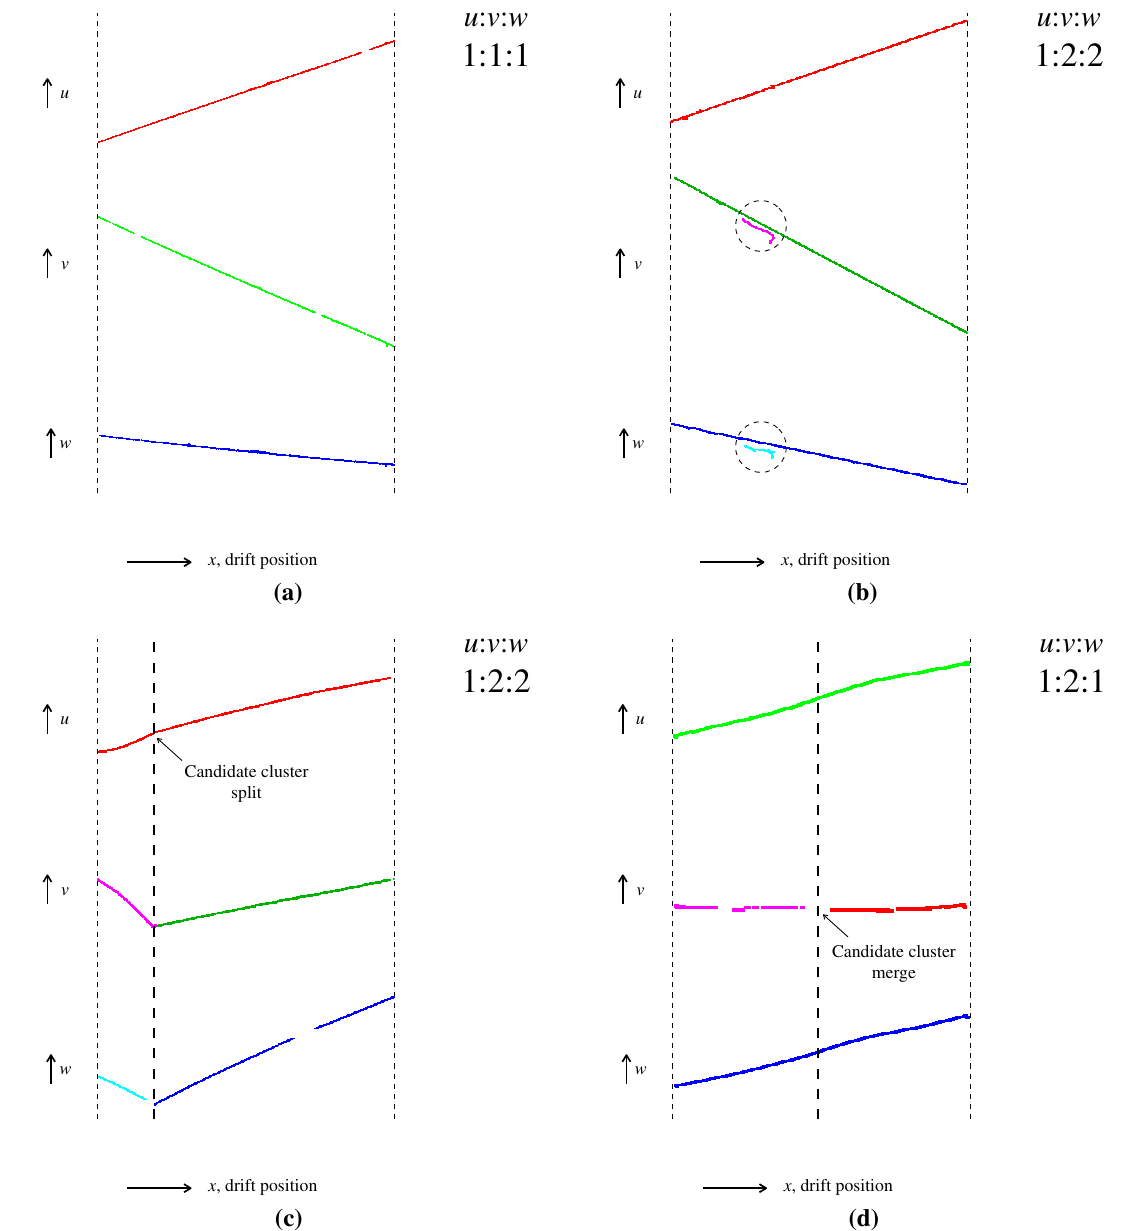
Fig. 4 Example topologies considered by the 3D track reconstruction, whichaimstoidentifyunambiguous groupings of2Dclusters,onefrom each readout plane. a An unambiguous grouping of clusters, with com- plete overlap in the common x coordinate. b The presence of two small delta-ray clusters (circled), near the muon tracks, means that the cluster matching is ambiguous, but the most appropriate grouping of 2D clus-